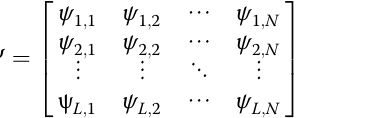
table composed of fð x j ; y the